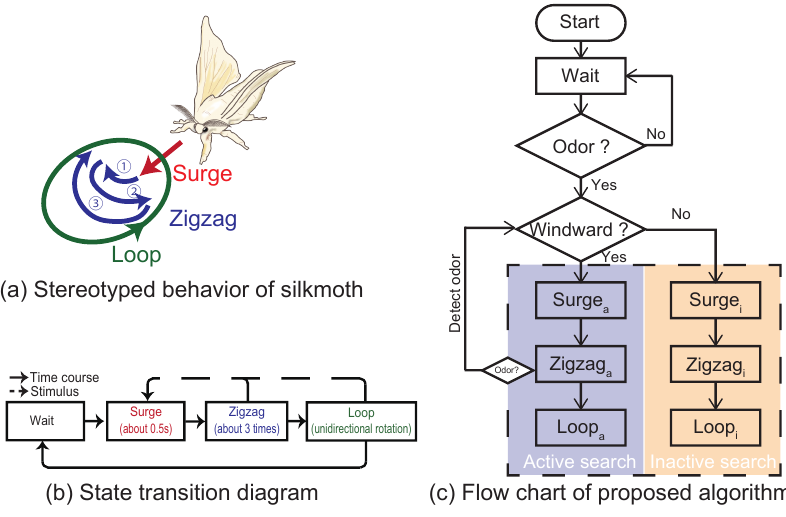
Figure 3. Outline of the typical behavioral patterns during female localization of the silk moth and flowchart of the proposed algorithm.